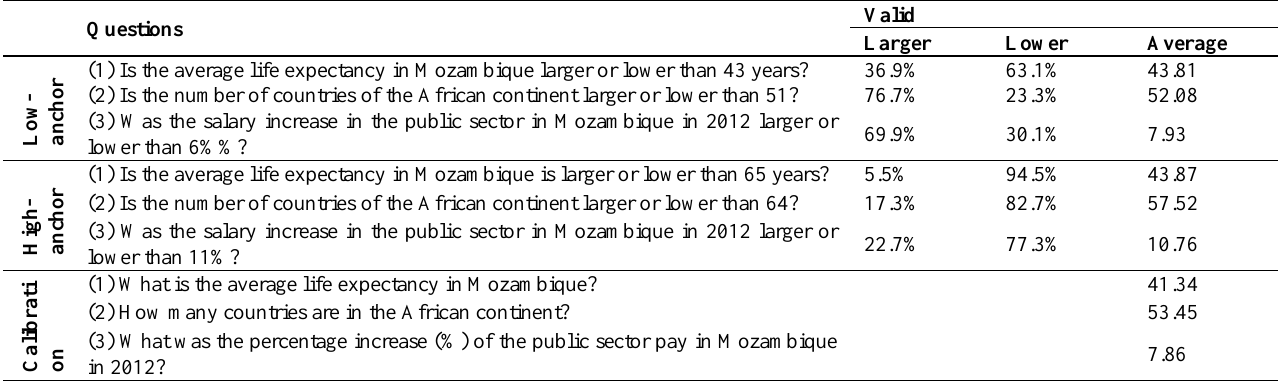
Table 7: Low- and high-anchor estimates